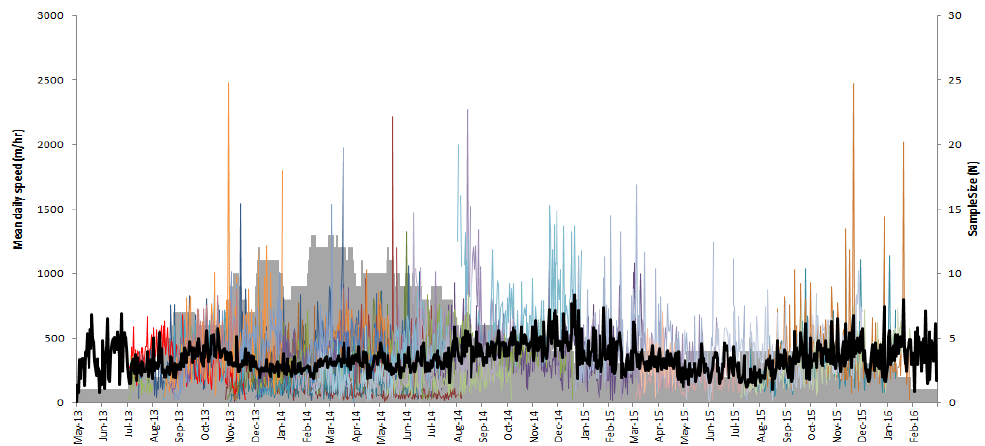
Figure 1. Mean daily activity levels for 34 urban wild dogs monitored in urban areas of north-eastern Australia, between May 2013 and March 2016. Solid line indicates the overall mean, grey area represents sample size.